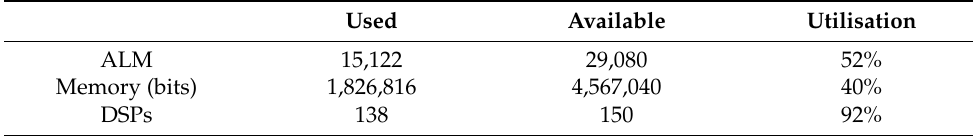
Table 1. Device utilisation